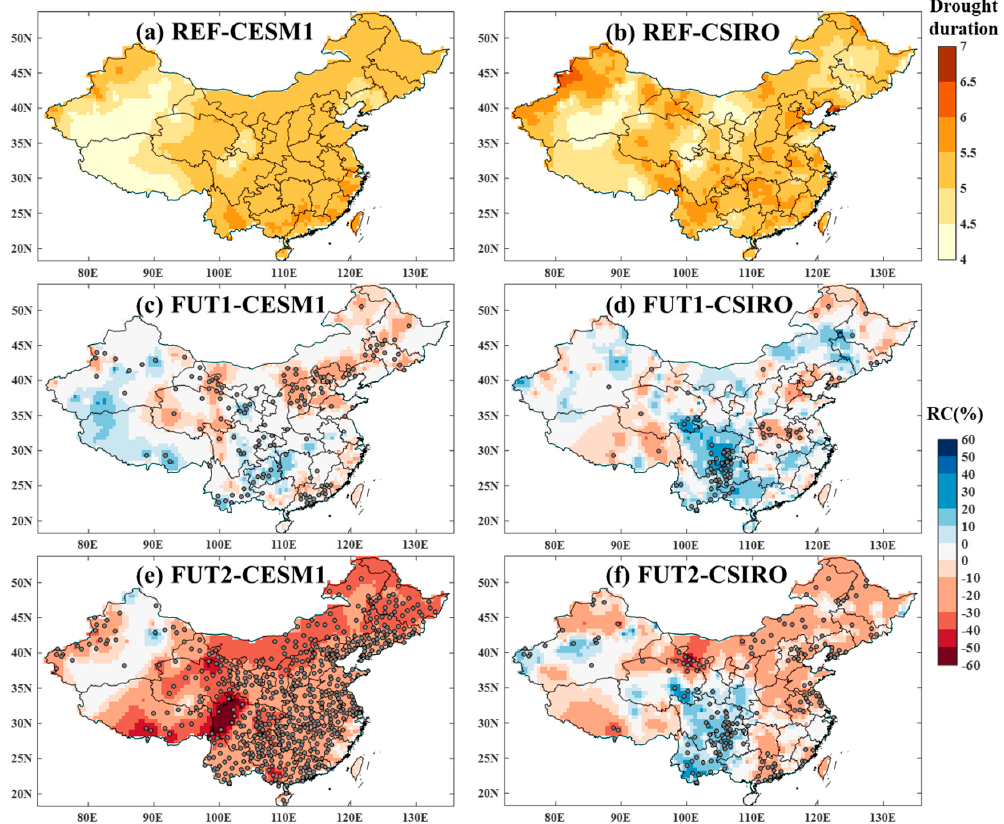
Figure 7. Spatial patterns of drought duration with a 30-year return period in the reference period (REF) and the relative changes (RC) in future periods (FUT1, FUT2) for two climate model ensembles. Stations that present statistically significant changes are marked with filled dots. ( a )The 30-year return period of drought duration in REF for CESM1; ( b ) The 30-year return period of drought duration in REF for CSIRO; ( c ) The RC of the 30-year return period of drought duration in FUT1 for CESM1; ( d ) The RC of the 30-year return period of drought duration in FUT1 for CSIRO; ( e ) The RC of the 30-year return period of drought duration in FUT2 for CESM1; ( f ) The RC of the 30-year return period of drought duration in FUT2 for